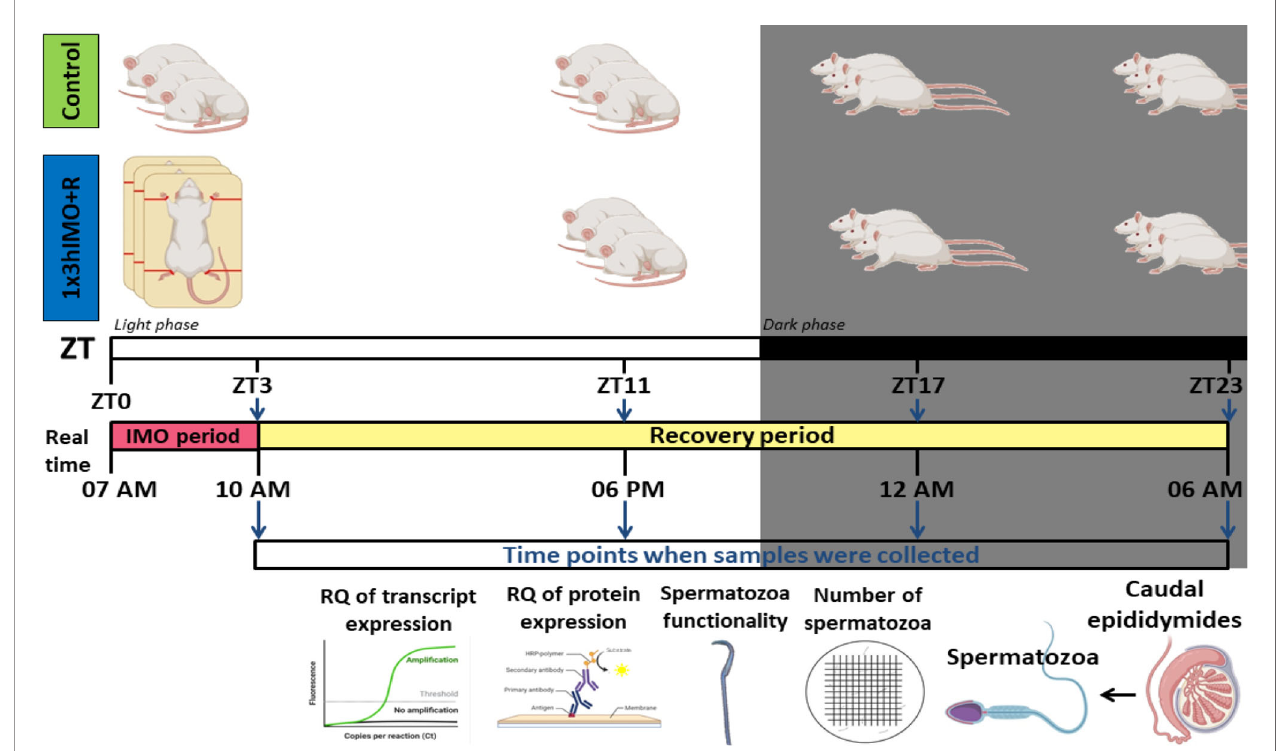
FIGURE 1 | Experimental design of immobilization stress with recovery period used to assess spermatozoa number and functionality (% acrosome reaction) as well as mitochondrial dynamics markers and related signaling molecule expression pro fi les of transcripts and